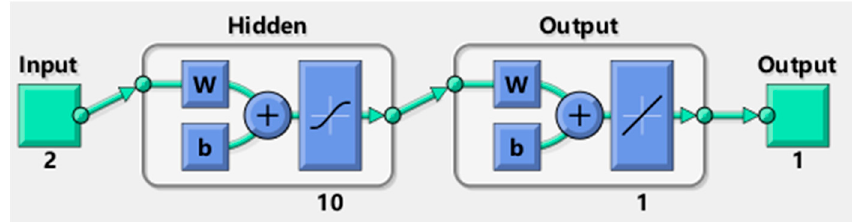
Figure 4. Diagram of back propagation (BP) neural network in Matlab.